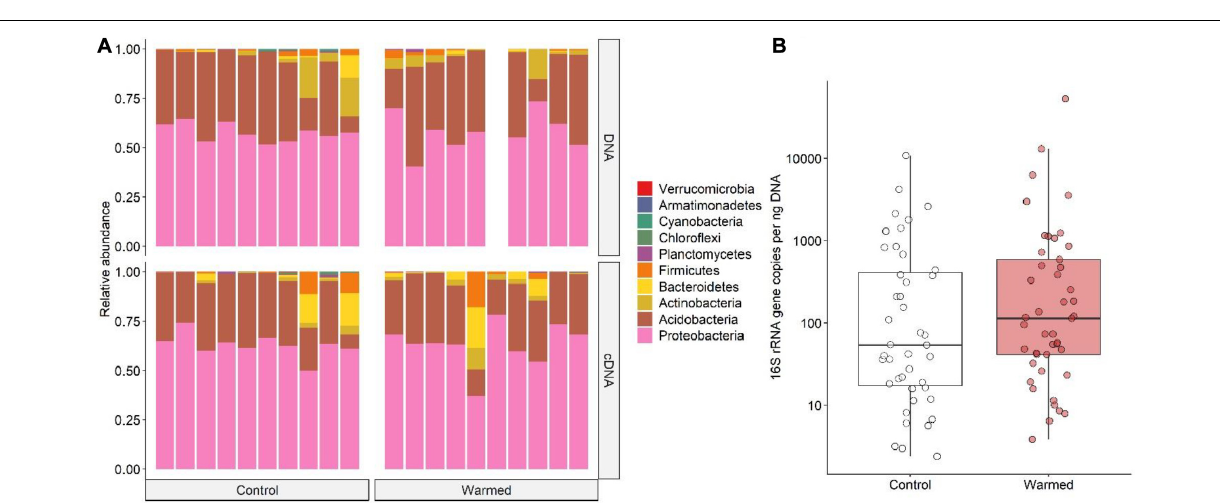
FIGURE 3 | (A) Barplots of the bacterial community composition associated with the lichen C. islandica in the control and warmed plots. Data are presented at the phylum level for DNA and cDNA. Bars represent pooled samples from each separate plot. (B) 16S rRNA gene abundance per ng extracted DNA in control (white) and warmed (red) samples. N = 88, n warmed = 45, n control =